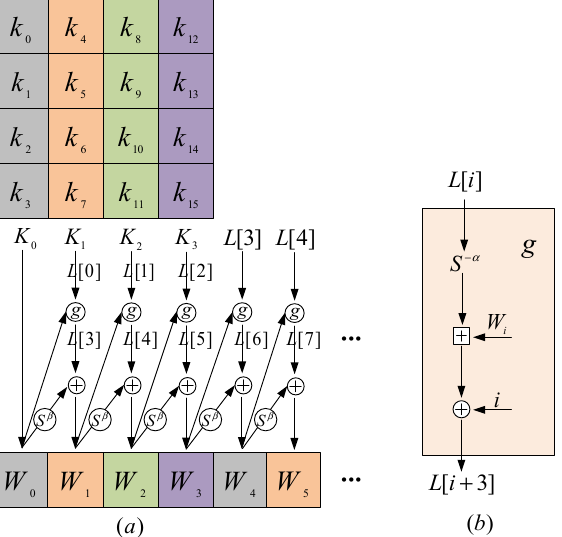
Figure 4. Schematic diagram of key expansion, they should be listed as: ( a ) represents the overall algorithm and ( b ) represents the function g.